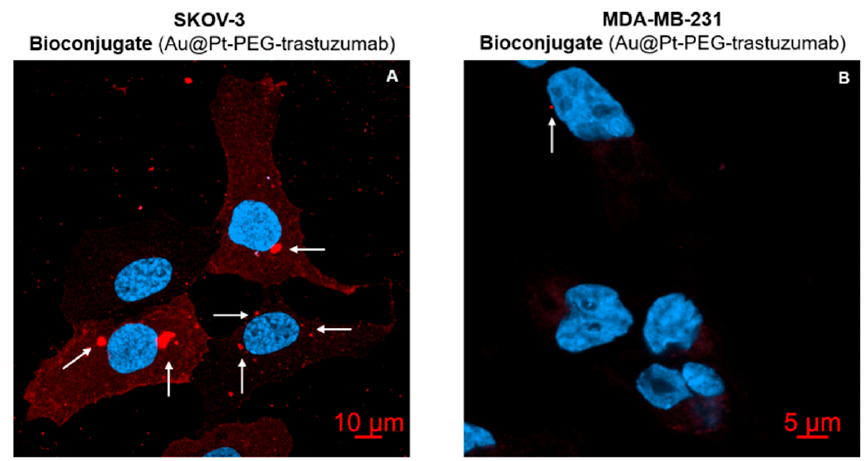
Figure 11. Merged 408/488 nm images for bioconjugate treated SKOV-3 and MDA-MB-231 cell line. Intensified red signal corresponds to bioconjugate accumulation (marked with white arrow).